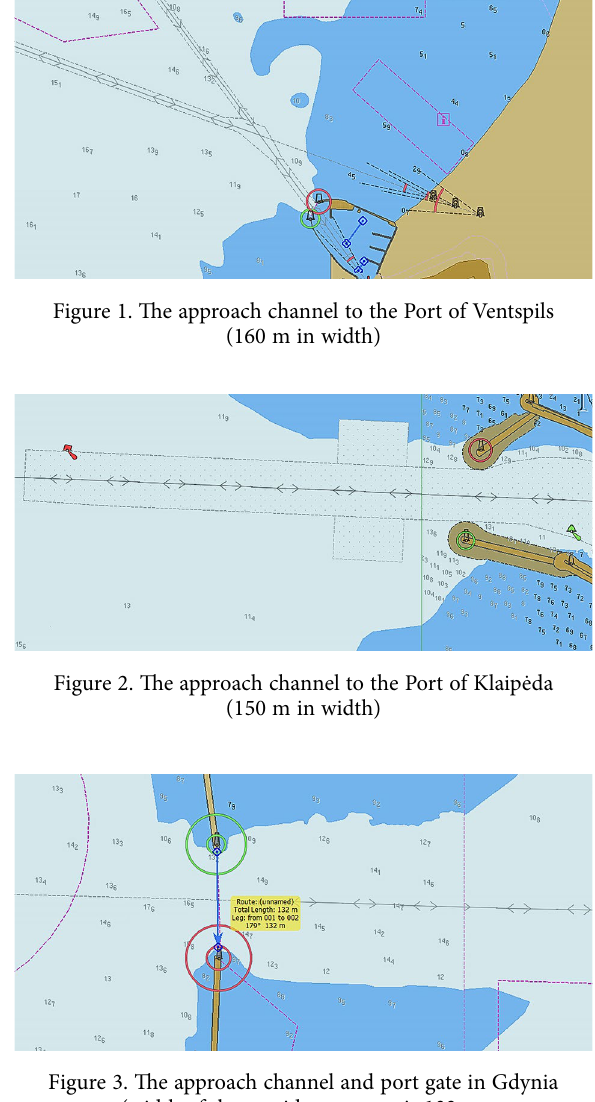
Figure 3. The approach channel and port gate in Gdynia (width of the outside port gate is 132 m, width of the inside port gate is 95 m)